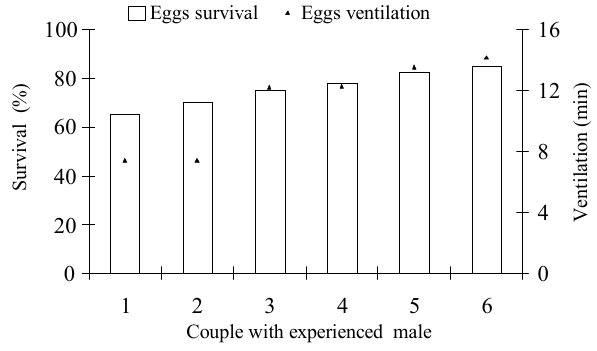
Fig. 2. Survival of the eggs in relation to care provided by experienced males through aeration (Pearson, p < 0.01).